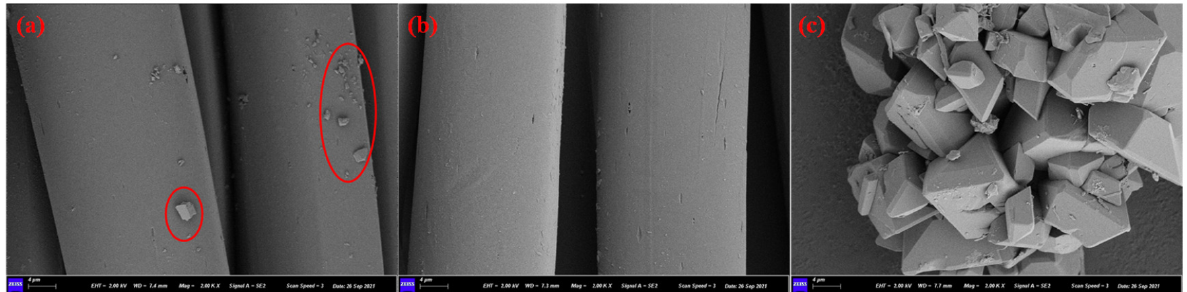
Figure 4. SEM images of original polyester ( a ), treated polyester ( b ) and oligomer ( c